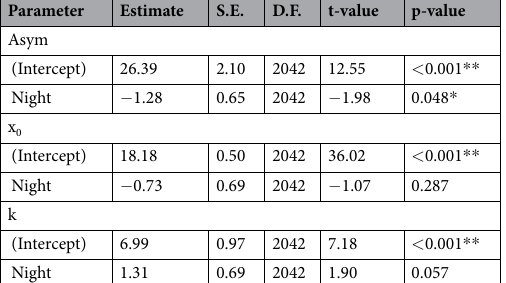
Table 3. Results of the non-linear mixed effects models testing the effect of the depth of the thermocline and the day/night period on mean fish depths. The fitted values for each parameter defining the logistic curve and their significance are shown: Asym = maximum value of the curve; x0 = x-value of the inflexion point; k = steepness of the